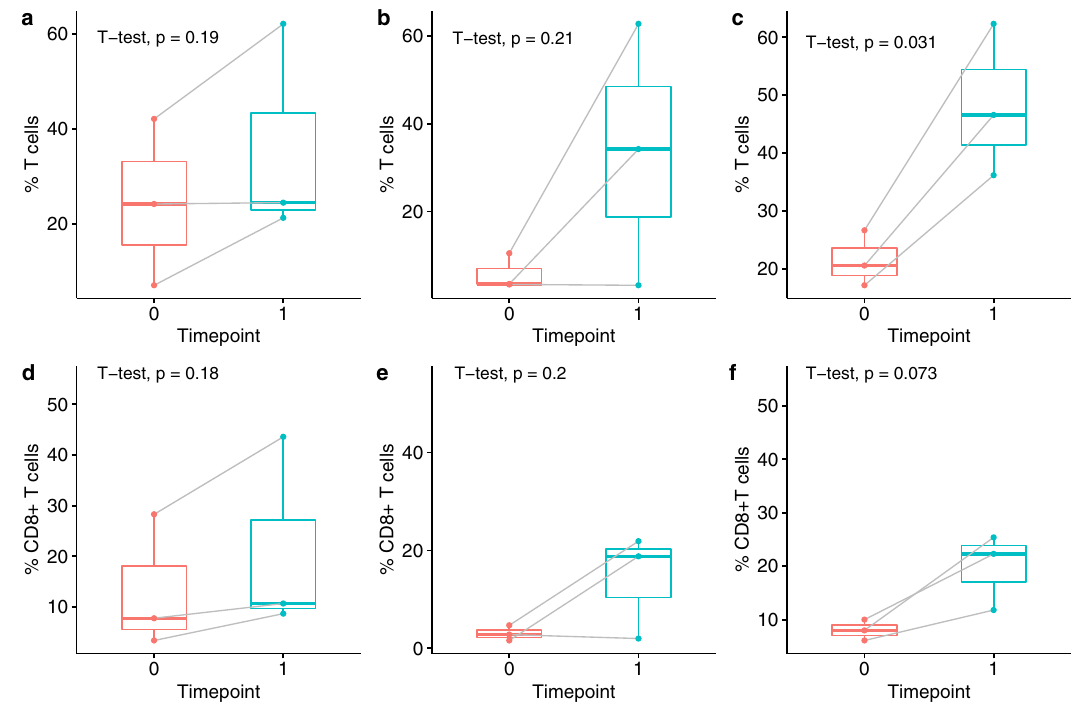
Fig. 2 T cell in fi ltrates increased in 7 of 9 cases across all three dose cohorts. Total T cell and CD8 + T cell density in response to 2 mg pembrolizumab ( a , d ), 4 mg pembrolizumab ( b , e ), and 8 mg pembrolizumab ( c , f ). Timepoint 0 (pre-therapy) and timepoint 1 (post-therapy) are shown. The bounds of each box represent the interquartile range (IQR). The horizontal line within a box is the median. Whiskers extend to the largest and smallest values no further than 1.5*IQR. Outlying points beyond the ends of the whiskers are plotted individually. Each pair of connected points represents one patient ’ s data; p -values are derived from paired t -tests.